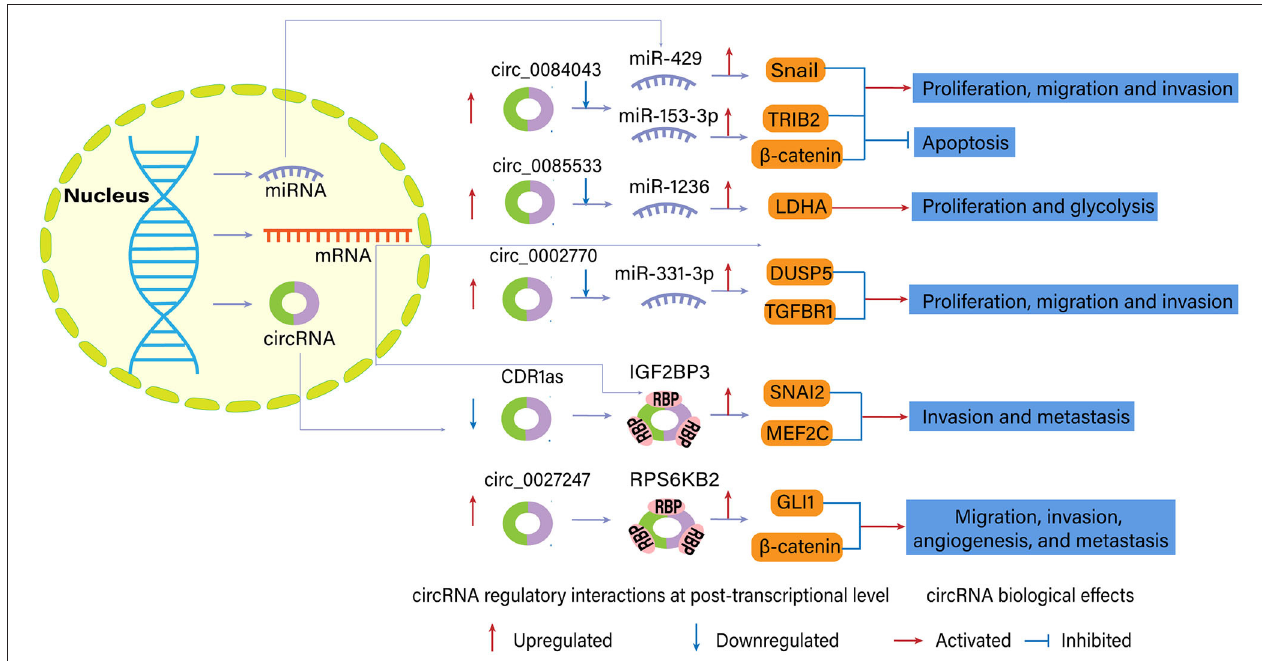
FIGURE 4 | Examples of regulatory interactions and biological effects of dysregulated circular RNAs (circRNAs) in melanoma (Luan et al., 2018; Chen J. et al., 2020; Chen Z. et al., 2020; Hanniford et al., 2020; Jin et al., 2020; Qian et al., 2020 ).